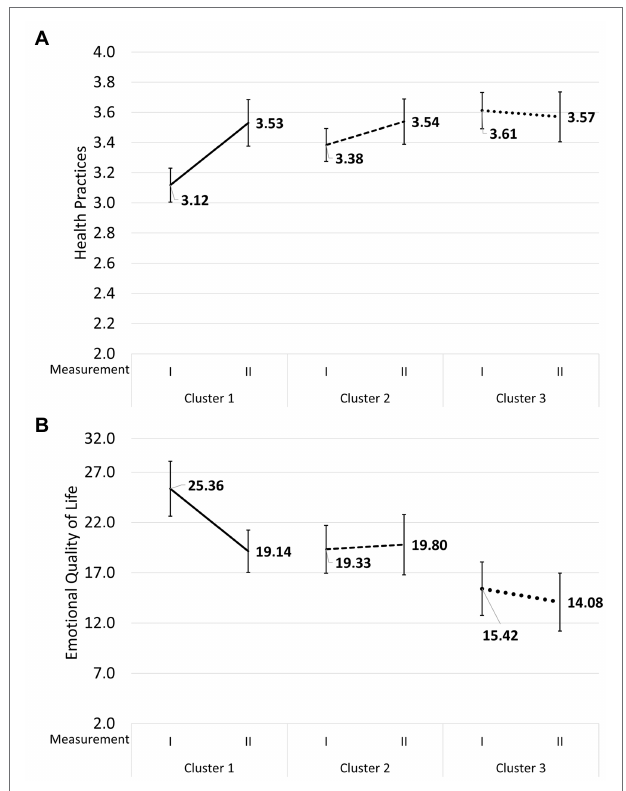
FIGURE 2 | Mean values and 95% confidence intervals for Health Practices (A) and Emotional Quality of Life (B) at the first and the second measurements in the group of patients with higher Neuroticism, Perseveration, and Emotional Reactivity, in the group of patients with higher Extraversion, Briskness, Sensory Sensitivity, Endurance, and Activity, and in the group of patients with lower